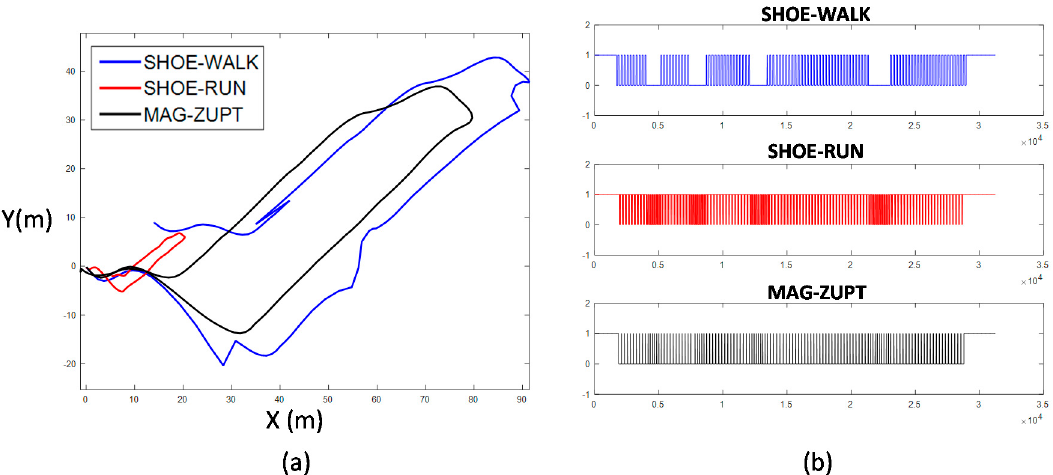
Figure 31. Positioning results and ZUPT comparison of Traj_4; ( a ) is the positioning result. Blue line and red line are the results of SHOE-ZUPT method whose threshold is adjusted to walking and running, respectively. Black line is the result of the novel mag-ZUPT method developed in this paper; ( b ) is the ZUPT result of SHOE-WALK, SHOE-RUN and mag-ZUPT. TTDE of mag-ZUPT is 0.77%. Traj_5 and Traj_6 are long distance indoor-outdoor tests. The start point is on floor